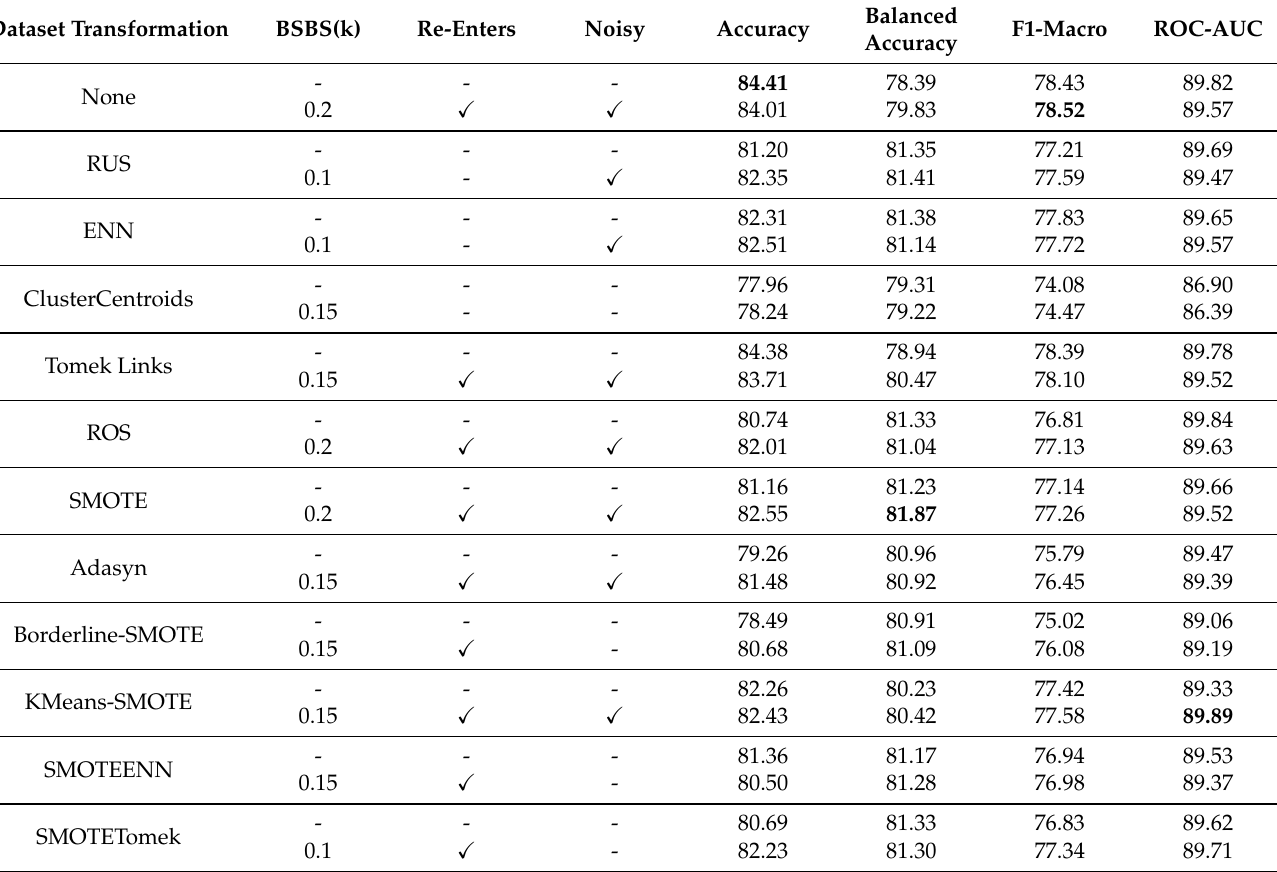
Table 4. Results for the Adult dataset.